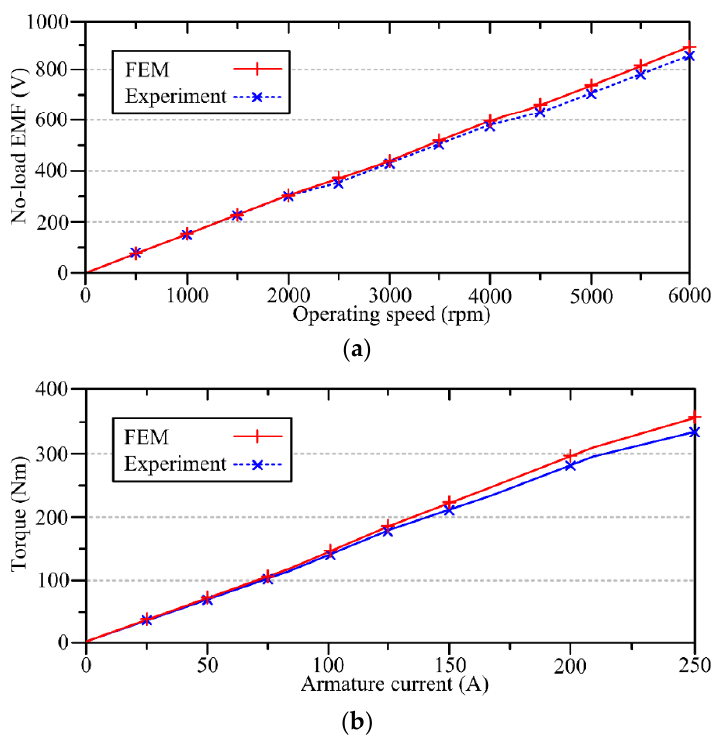
Figure 4. Comparisons between theoretical and experimental results of benchmark interior permanent-magnet (IPM) motor: ( a ) Back-EMFs; ( b ) Locked torques.